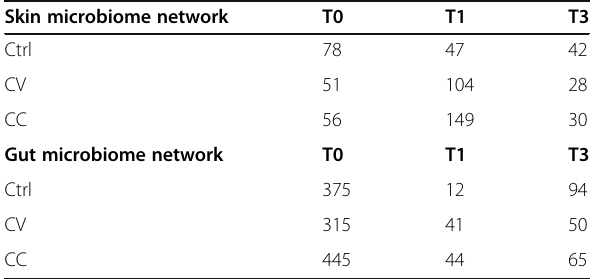
This table resumes the number of modules obtained from MCL clustering of edge betweenness (see Materials and Methods) of skin and gut